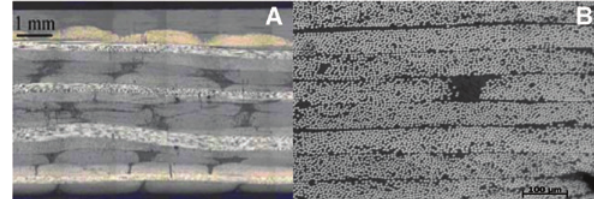
Figure 1: Image of laminate cross sections.